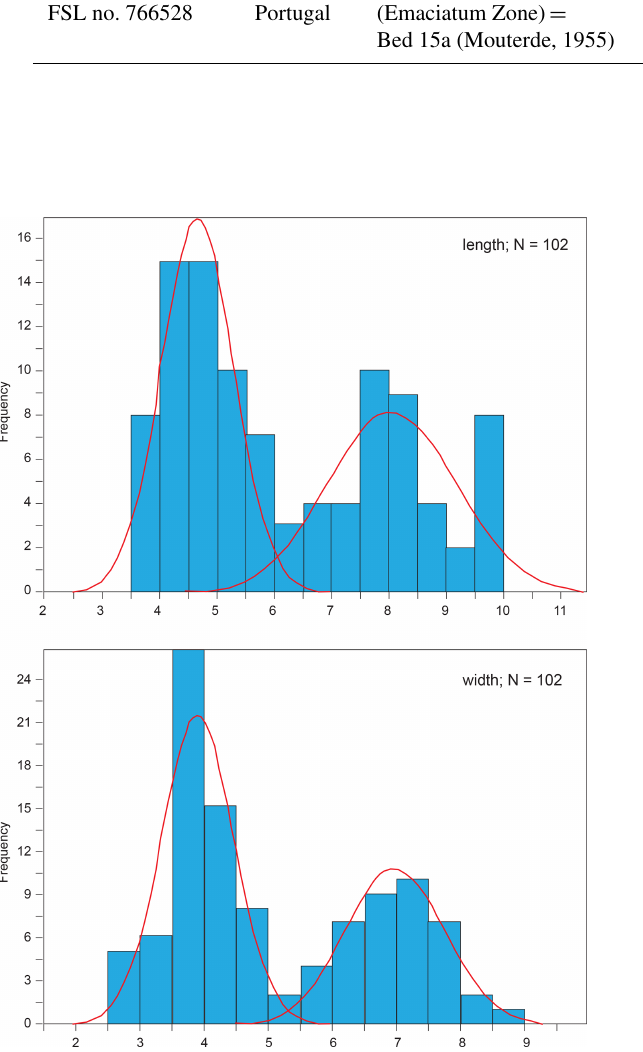
Figure 1. Mixture analysis applied to the length and width of all the analysed coccoliths using PAST 3.01 software (Hammer et al., 2001). The lowest Akaike information criterion (AIC, Akaike, 1973) is obtained with two populations with modes at 4.0–5.0 and 7.5–8.5µm for coccolith length and at 3.5–4.5 and 6.5–7.5µm for coccolith width. The number of size classes or bins was chosen in order to obtain each bin at